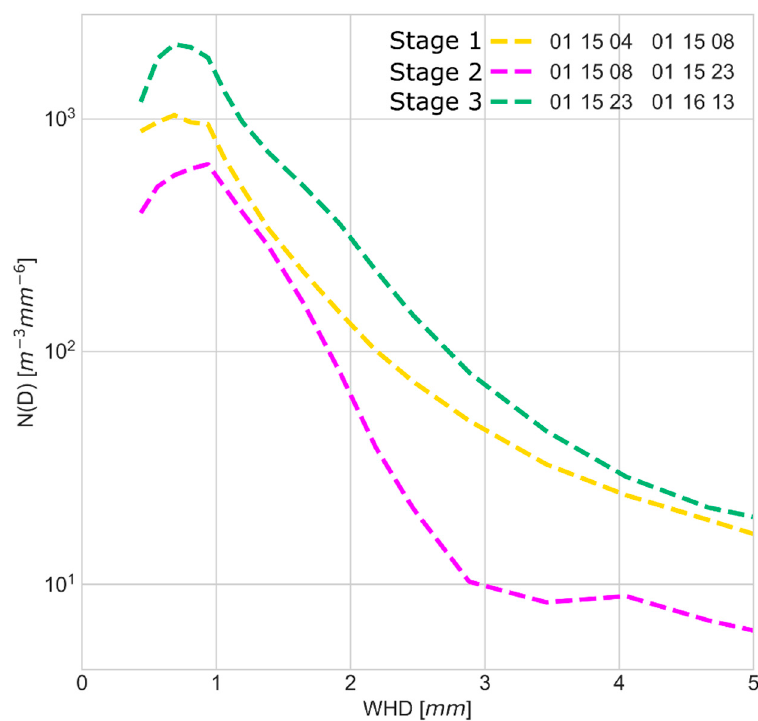
Figure 8. Hydrometeor Particle Size Distribution N(D) measured by Parsivel disdrometer for the three di ff erent storm stages studied. Dates are indicated considering the format MM-DD HH (month-day hour) in UTC.